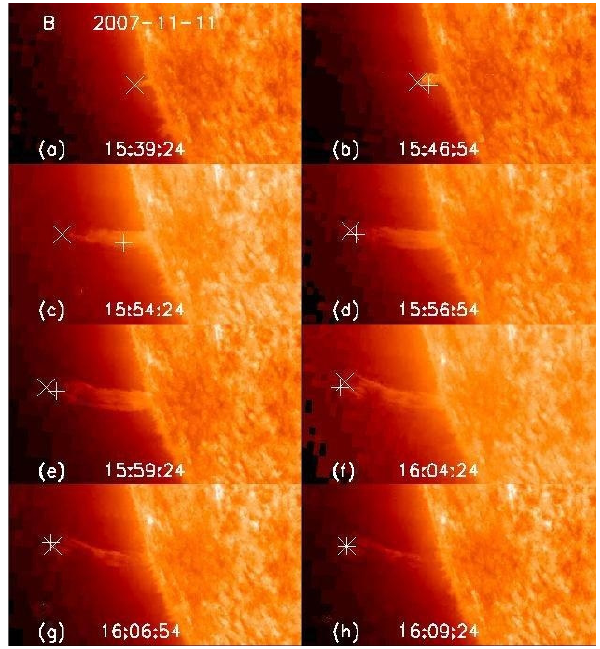
Fig. 3. Equatorial jet on 11 November 2007 seen by STEREO B at 304 ˚A. In each frame, the cross indicates the current position of the leading edge, while the plus sign indicates the same position in the previous frame.